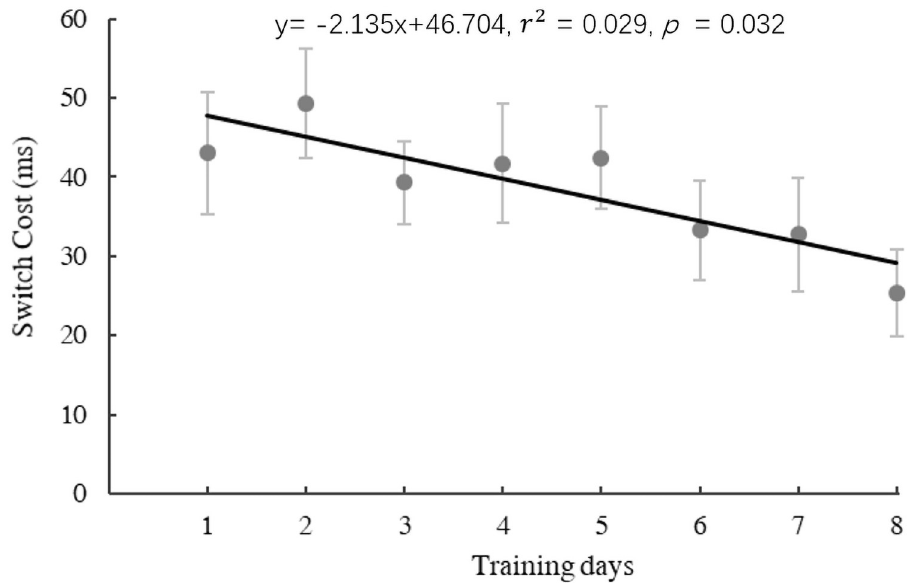
Fig 2. The scatter plot and significant regression line across 8-day training in the experimental group. Switch cost = switch–non-switch, L1 slowing effect = L1 –L2.